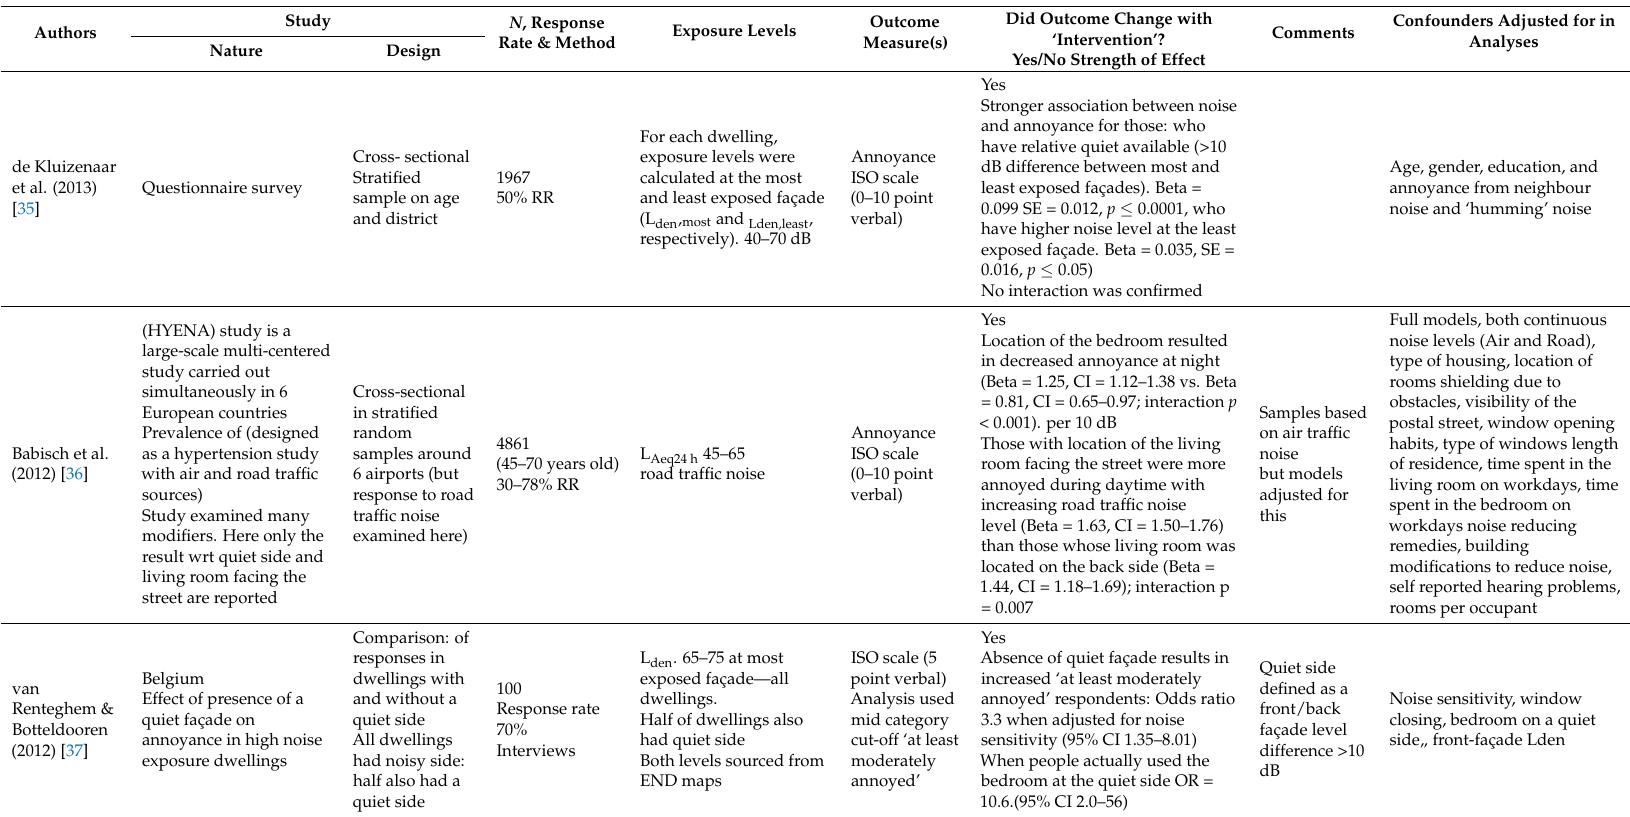
Table 6. Other Physical Intervention (Type